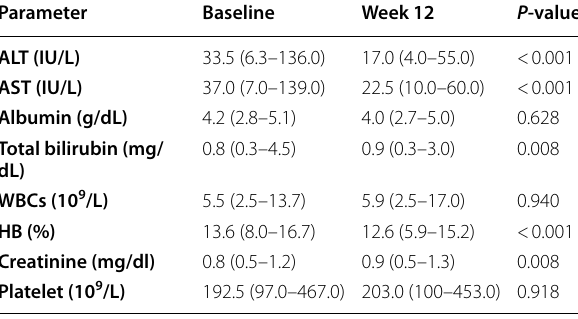
Table 3 Comparing baseline and end of treatment data in